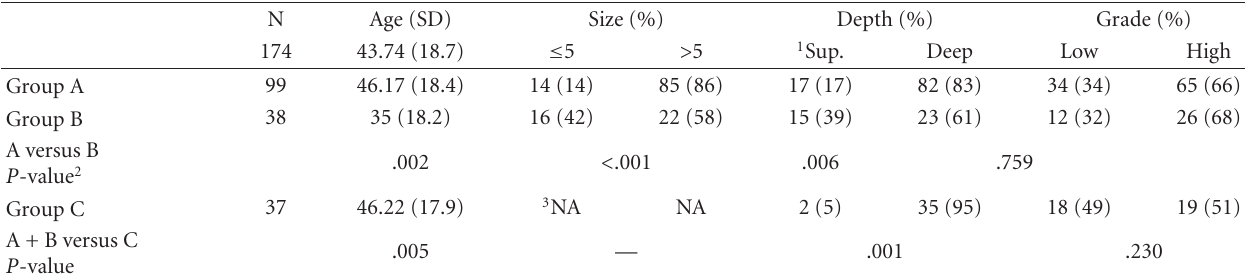
Table 1: Data on size, depth, and grade in the di ff erent STS groups